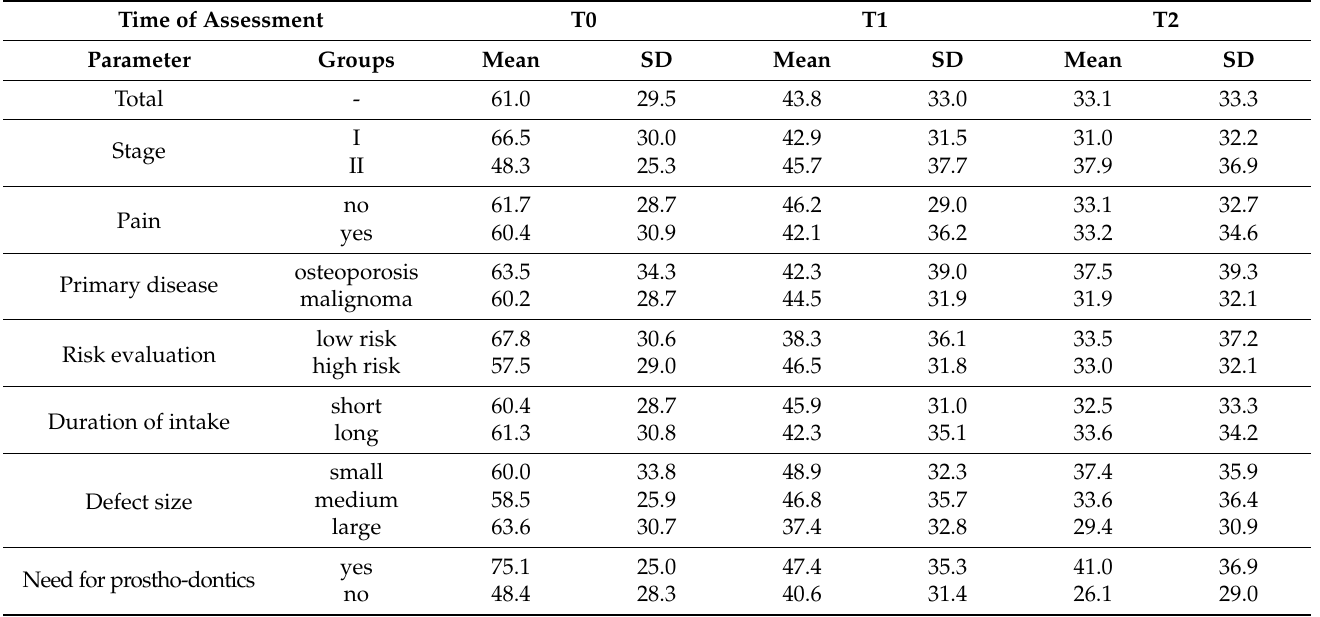
Figure 3. Total VAS1 score at baseline (T0), first (T1) and second (T2) follow-up assessments. Significant changes were observed for pain, risk evaluation, duration of drug intake, defect size, need for prosthodontics, and dental status between T0 and T1, T0 and T2, and T1 and T2 (all F [1,34] ≥ 4.969, all p ≤ 0.012, all partial- η 2 [min to max] = 0.128 to 0.390). With regard to the stage, values significantly improved from T0 to T2 (F [1,34] ≥ 13.374, p ≤ 0.001, partial- η 2 [min to max] = 0.103 to 0.135) and in primary disease, values decreased significantly from T0 to T1/T2 (all F [1,34] ≥ 6.301, all p ≤ 0.001, partial- η 2 = 0.282). VAS1 values showed no significant main effect between groups (all F [1,34] < 0.074, all p > 0.086, partial- η 2 [min to max] = 0.002 to 0.073) and no statistically significant time by group interactions (Greenhouse–Geisser, all F [2,68] < 0.074, all p > 0.195, partial- η 2 [min to max] = 0.002 to 0.073). Mean VAS1 values are shown in Table 5. Table 5. VAS1 values for all parameters and assessment times (T0/T1/T2). SD: standard deviation.